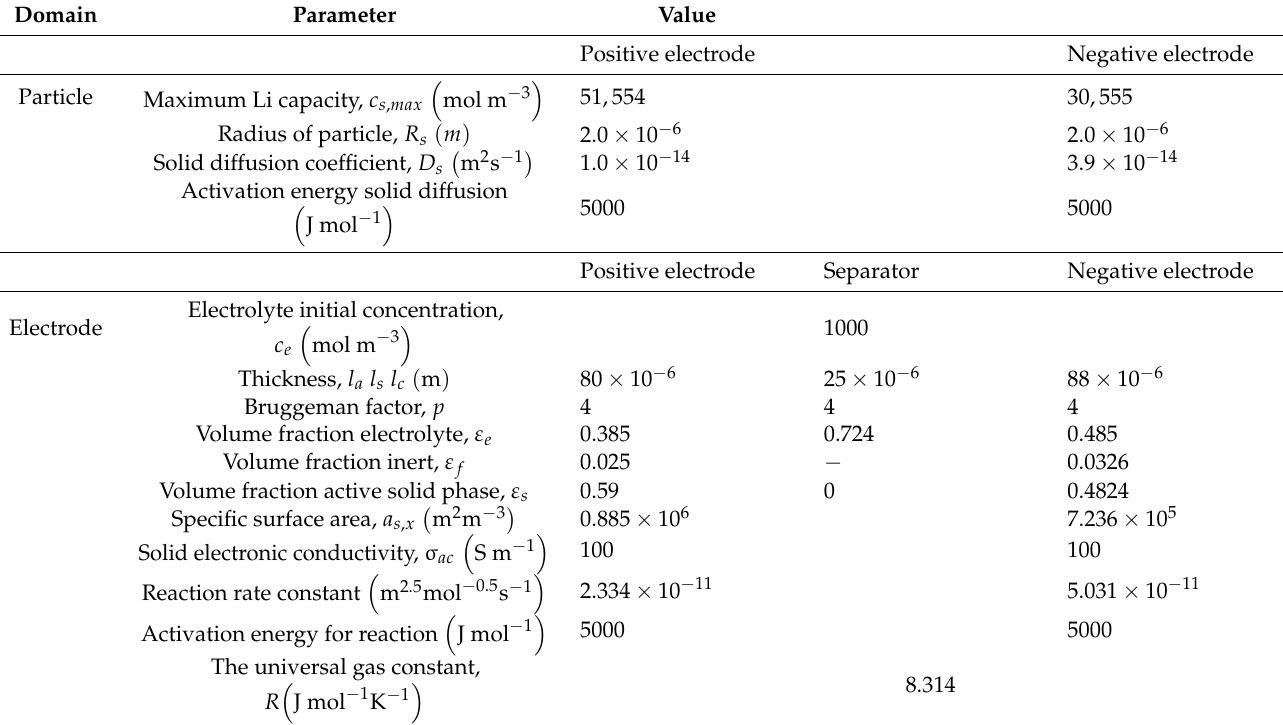
Table 4. Summary of model parameters.